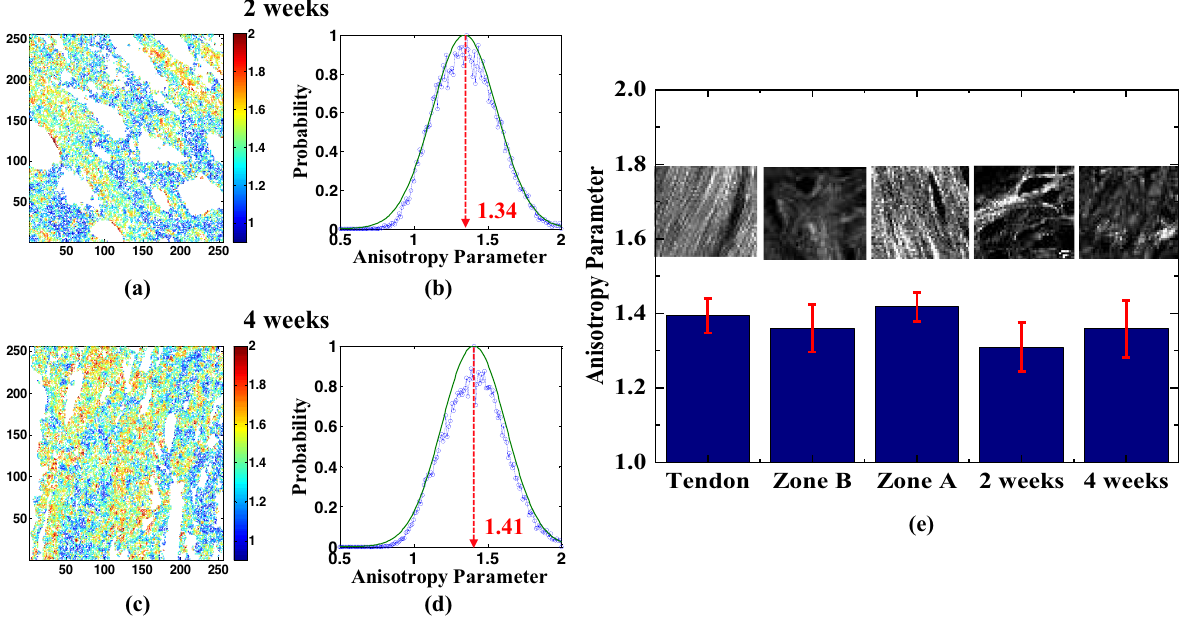
Figure 4. AP maps and corresponding AP histograms for ( a , b ) bone fracture repair at 2 weeks and ( c , d ) bone fracture repair at 4 weeks. ( e ) Averaged AP values for tendon, articular cartilage (Zone B), cortical bone (Zone A), fracture repair at 2 weeks, and fracture repair at 4 weeks. Error bars represent standard error of mean. The image size is 50 × 50 μm 2 . The bar graph corresponding to the collagen II rich healing tissue at 2 weeks and collagen I rich healing tissue at 4 weeks exhibits a gradual reduction of collagen II along with the simultaneous increase of collagen I. The healing tissues are significantly different at p < 0.05. All the image maps, histograms, and bar graphs were generated by using MATLAB R2019a (Version: 9.6.0.1072779, https:// www. mathw orks. com/ produ cts/ new_ produ cts/ relea se201 9a. html).